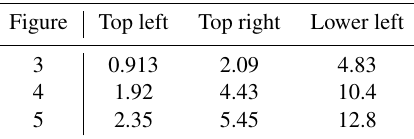
Table 1. Total mass loadings of organics used in Sect. 4 that are dis- tributed between the volatility bins using the anthropogenic volatil- ity distribution given in Table 3. Concentrations are given in µgm − 3 at 293.15K and 950hPa.